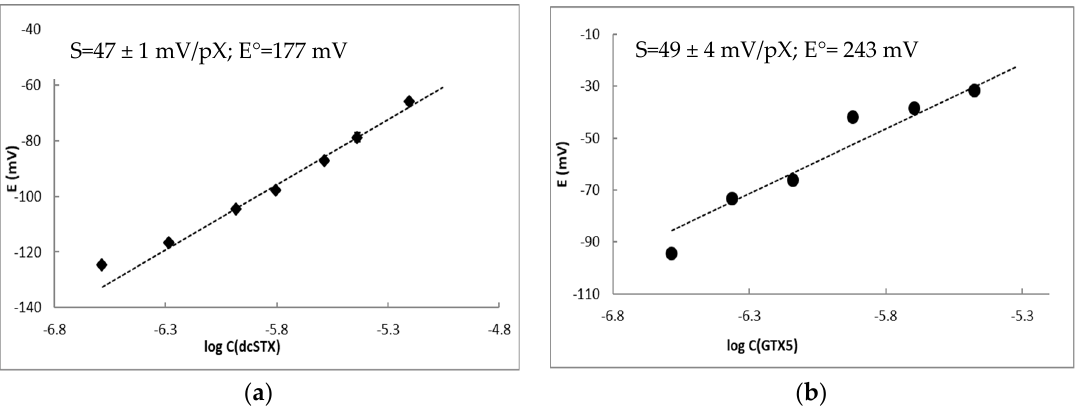
Figure 6. Sensor responses in the solutions of dcSTX ( a ) and in the solutions of dcSTX formed during enzymatic hydrolysis of GTX5 ( b ) prepared in 1 mmolL − 1 phosphate buffer. Parameters of the sensor response in dcSTX solutions and enzymatic assay were calculated in the concentration ranges from 0.52 to 6.24 µmolL − 1 ( a ) and from 0.43 to 3.34 µmolL − 1 ( b ), respectively, are shown in the insets: S—slope of the electrode function with standard deviation and E°—standard potential.